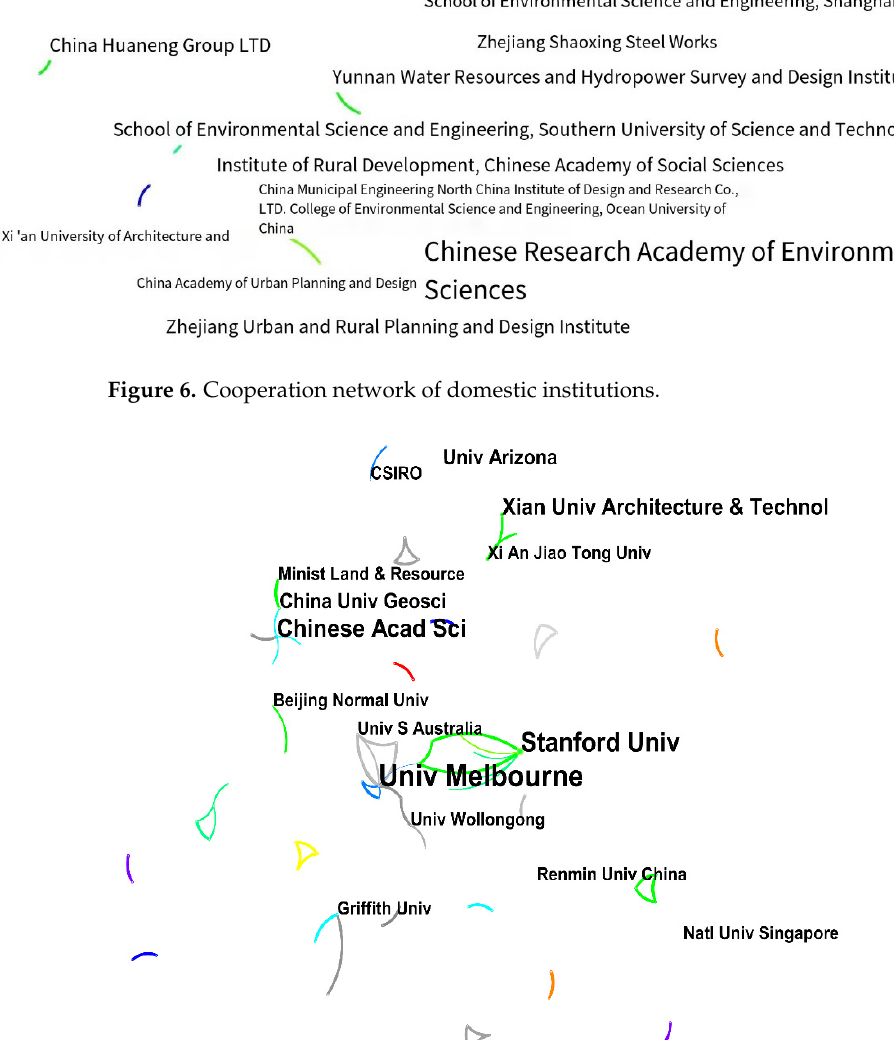
Figure 7. Cooperation network of international institutions. Table 3. Comparison of number of publications by research institutions (top 10).